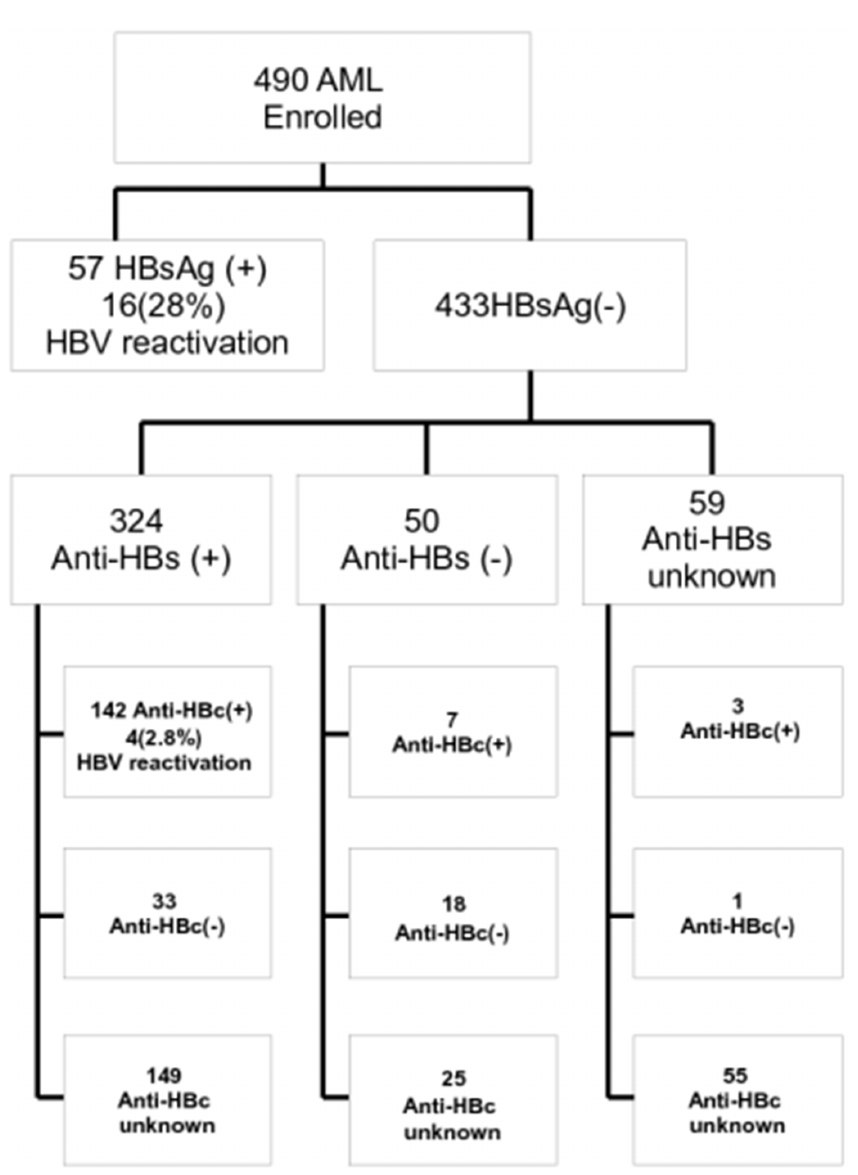
Fig 1. Study flow and hepatitis B serological data of 490 AML patients at Leukemia Diagnosis. 0.985 – 8.193), and positive HBsAg (p < 0.001, OR = 36.878, 95% CI: 11.770 – 115.547) were inde- pendent predictors of hepatitis B reactivation among AML patients. The subgroup analysis for HBV reactivation in 57 HBsAg-positive patients is shown in Table 3. Univariate analysis showed diabetes mellitus was associated with higher risk of HBV reactivation (p = 0.005) and antiviral therapy with less risk of hepatitis B reactivation (p < 0.001). Multivariate analysis showed that HBsAg positive patients who had received antivi- ral therapy had significantly lower risk of hepatitis B reactivation (p = 0.033, odds ratio (OR) = 0.094, 95% confident interval (CI): 0.025 – 0.355). Four of 142 negative HBsAg AML patients had hepatitis B reactivation. Their unusual clini- cal courses are shown in Table 4. All four patients had seroconverted with positive anti-HBsAb